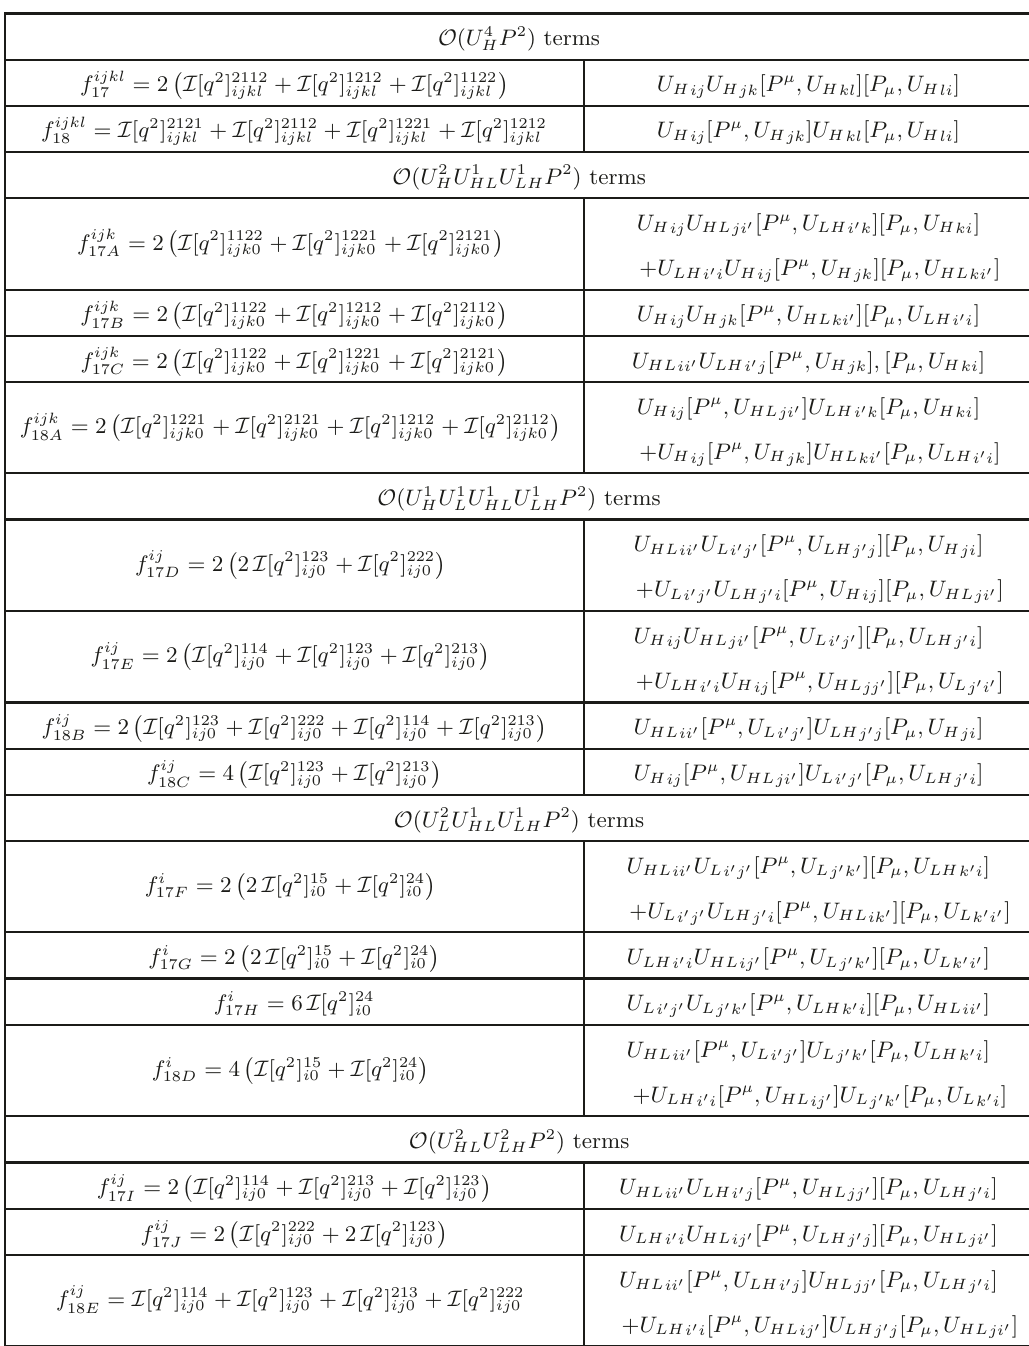
, f ijkl , f ijk , f ij , f i , f ij , f ijk , f ij , f i and 17 18 17 F,G,H 18 D 17 A,B,C 17 D,E 17 I,J 18 A 18 B,C